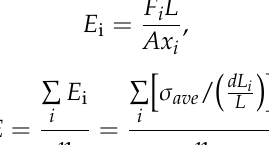
Table 2. Kullback–Leibler (KL) divergence between autocorrelation functions.